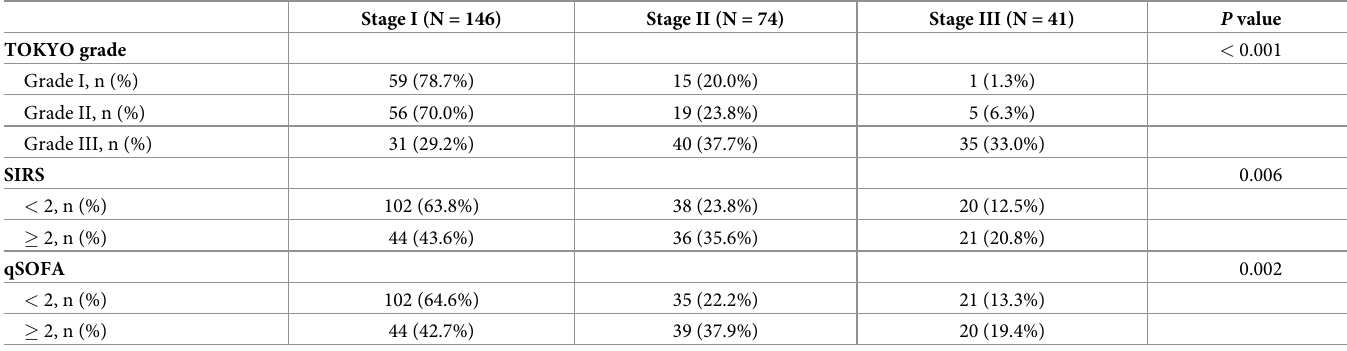
Table 3. The relationship between TOKYO grade, SIRS, and qSOFA and AKI stage determined by KDIGO